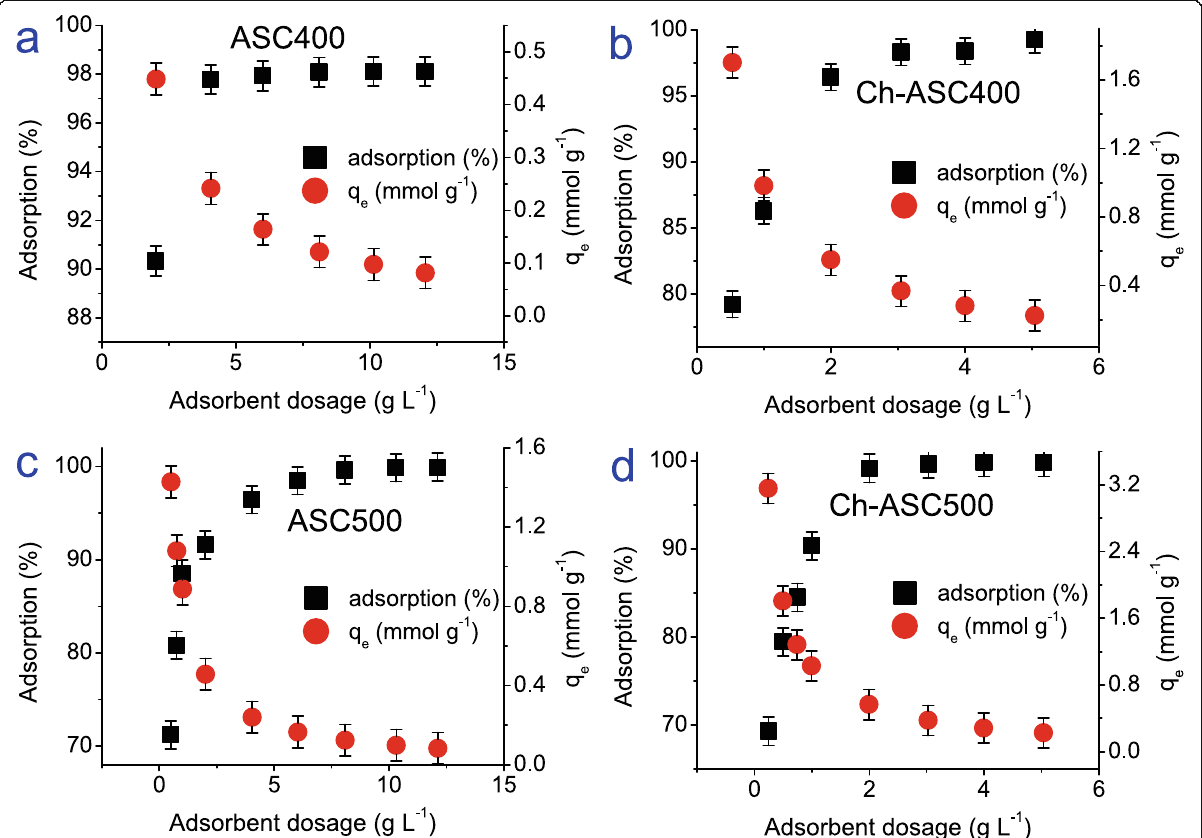
Fig. 7 Effect of adsorbent dosage on Cr(VI) adsorption; a for ASC400, b for Ch-ASC400, c for ASC500, d for Ch-ASC500 (adsorption conditions: initial Cr(VI) concentration: 55 mg L − 1 ; contact time: 120 min; pH: 1.5; temperature: 25